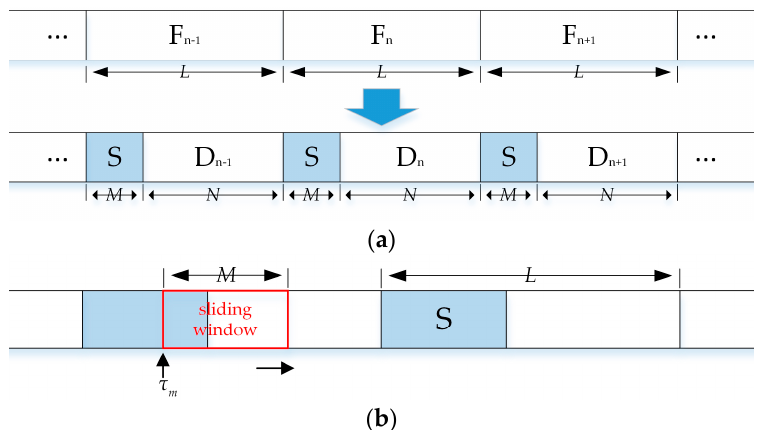
Figure 1. Received frame sequence. F, frame; S, frame synchronization word; D, payload; L , frame length; M , synchronization word length; N , payload length; ( a ) diagram of frame sequence with fixed synchronization word inserted.; ( b ) sliding window starting from τ m .